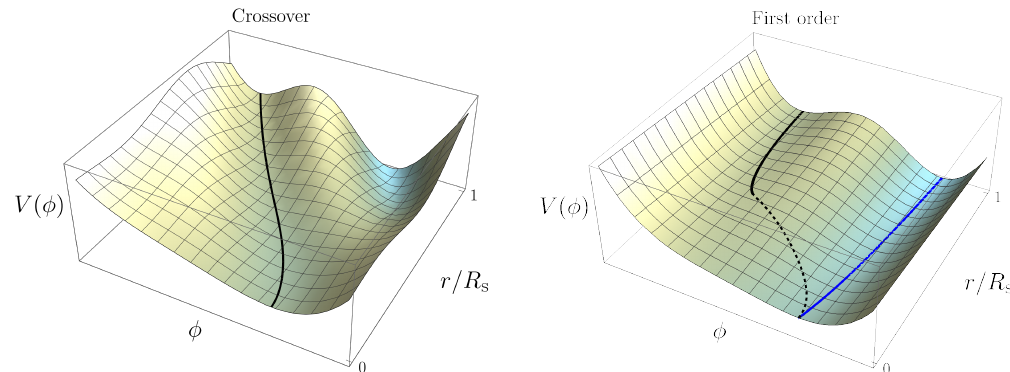
Figure 4: Crossover (left) versus first order phase transition (right) induced by a dense system (spherically symmetric and of finite size). For both cases the potential = 0 the center of the star. The black solid is shown as a function of radius, with r / R S > 1) minimum lines illustrate the scalar profile starting from a given in-vacuo ( r / R S and following it inside the star. For a first-order phase transition, the black line stops where this minimum ceases to exist. The dashed line then illustrates the field profile that connects to the minimum within the star. The profile unavoidably passes through regions where dV / d φ ̸ = 0, implying there are effective forces acting on the field. These forces give rise to the possibility that the initial scalar profile (black) classically changes to a new minimum in vacuum